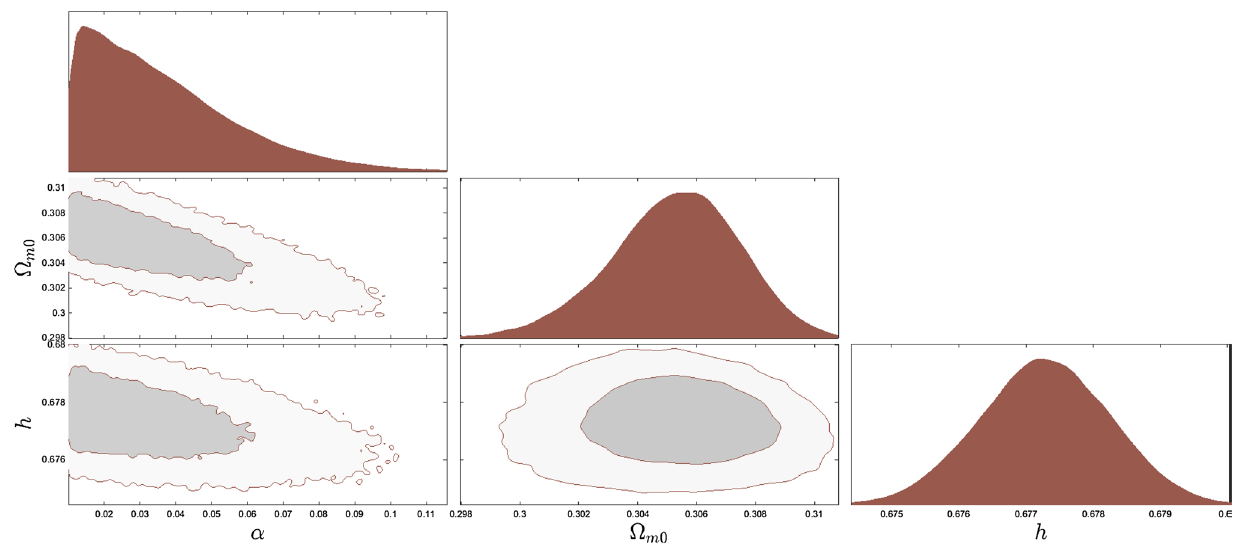
Fig. 3 The2 σ confidence levelcontour plots for various pairs ofthe free parameters( α , Ω m0 , h )for whichthe φ CDMmodelwiththe Ratra-Peebles φ − α is in the best fit with the Λ CDM model potential V (φ) = V 0 M 2 pl